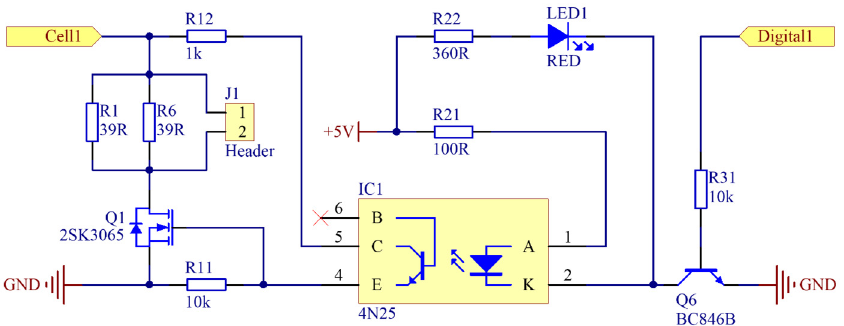
Figure 5. Part of the “Balancing” schematic sheet.